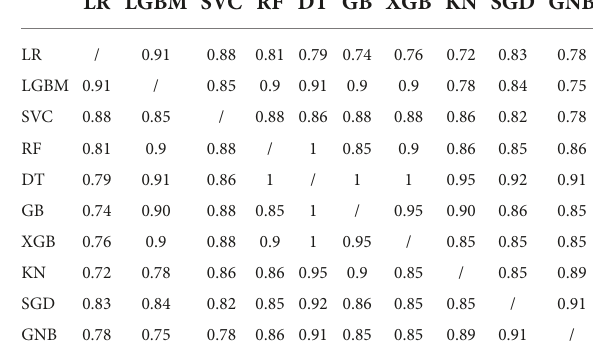
TABLE 6 P -values of McNemar’s tests between the ML